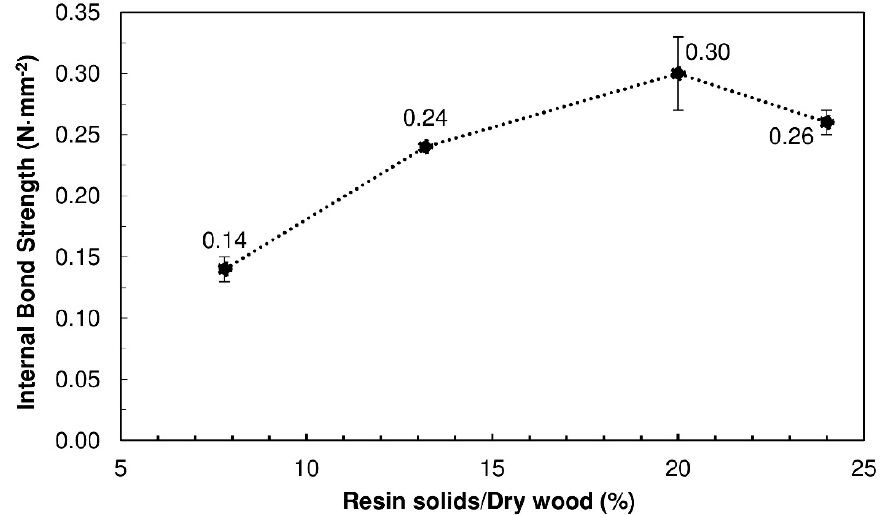
Figure 1. Internal bond (IB) strength of the wood particleboards (PBs) produced with thick spent sulfite liquor (TSSL) at different binder solids percentages (7.8%, 13.2%, 20.0%, and 24.0%); the PBs were manufactured at a pressing temperature of 190 °C and pressed for 600 s.